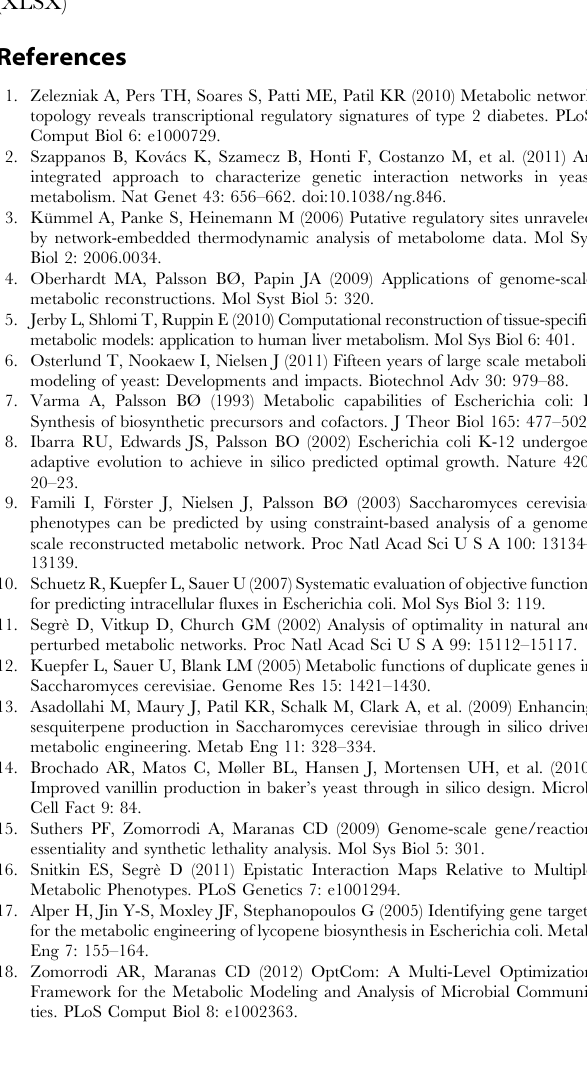
The top plots present the sensitivity for positive ( a ) and negative ( b ) interactions for FBA and MiMBL. The epistasis score cutoff of |0.13| is represented by a dashed line. The bottom plots present the precision for positive ( c ) and negative ( d ) interactions for FBA and MiMBL. The epistasis score cutoff of |0.13| is represented by a dashed line. Table S1 Number of lMoMA-predicted lethal gene/reaction knockouts in S. cerevisiae that differ between alternative represen- tations of stoichiometry (S 1 and S 2 ), relative to S 0 . (DOCX) Table S2 lMoMA-predicted epistatic interactions within S. cerevisiae genome-scale metabolic model. Table S3 MiMBL-predicted epistatic interactions within S. cerevisiae genome-scale metabolic model. Table S4 All significant genetic interactions among non-essential genes from Szappanos et al. involving genes contained in i AZ900 model included in the